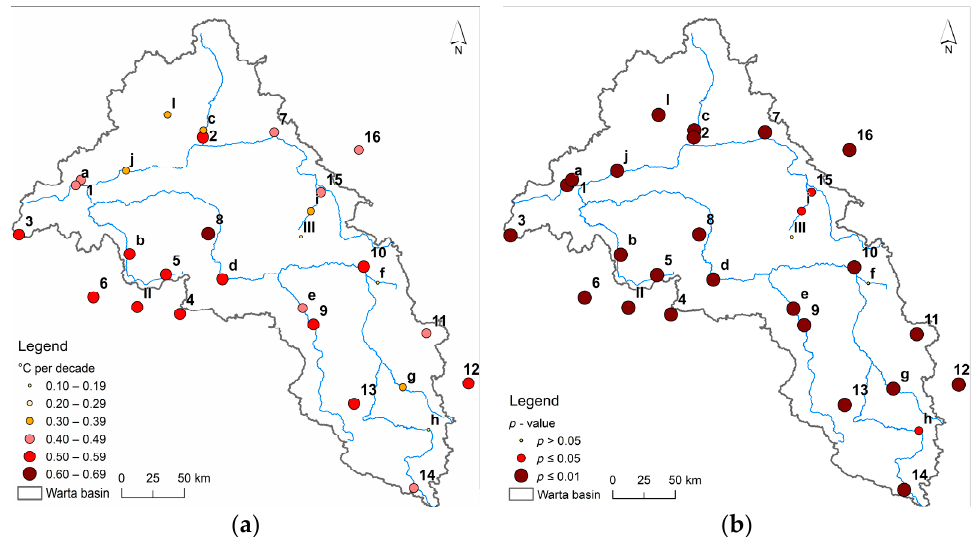
Figure 2. Changes in mean annual air and water temperatures in rivers and lakes: ( a ) Rate of changes in °C per decade and ( b ) significance of the changes.